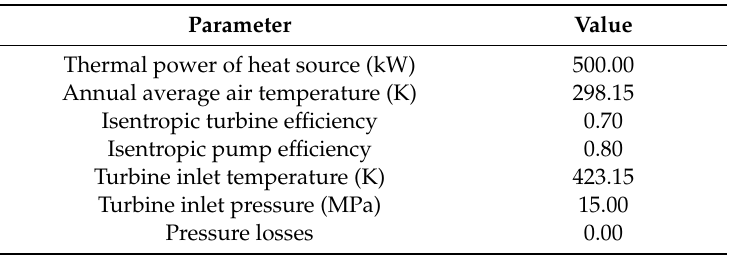
Table 1. Design operation